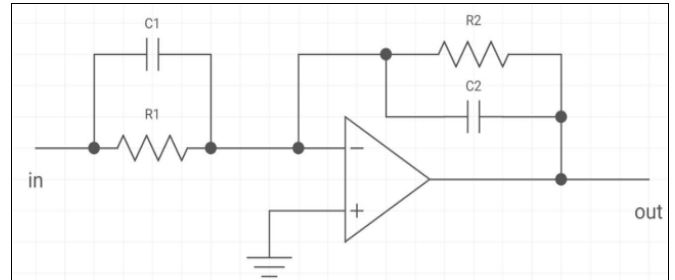
Figure 1: Lead Compensator (R1C1>